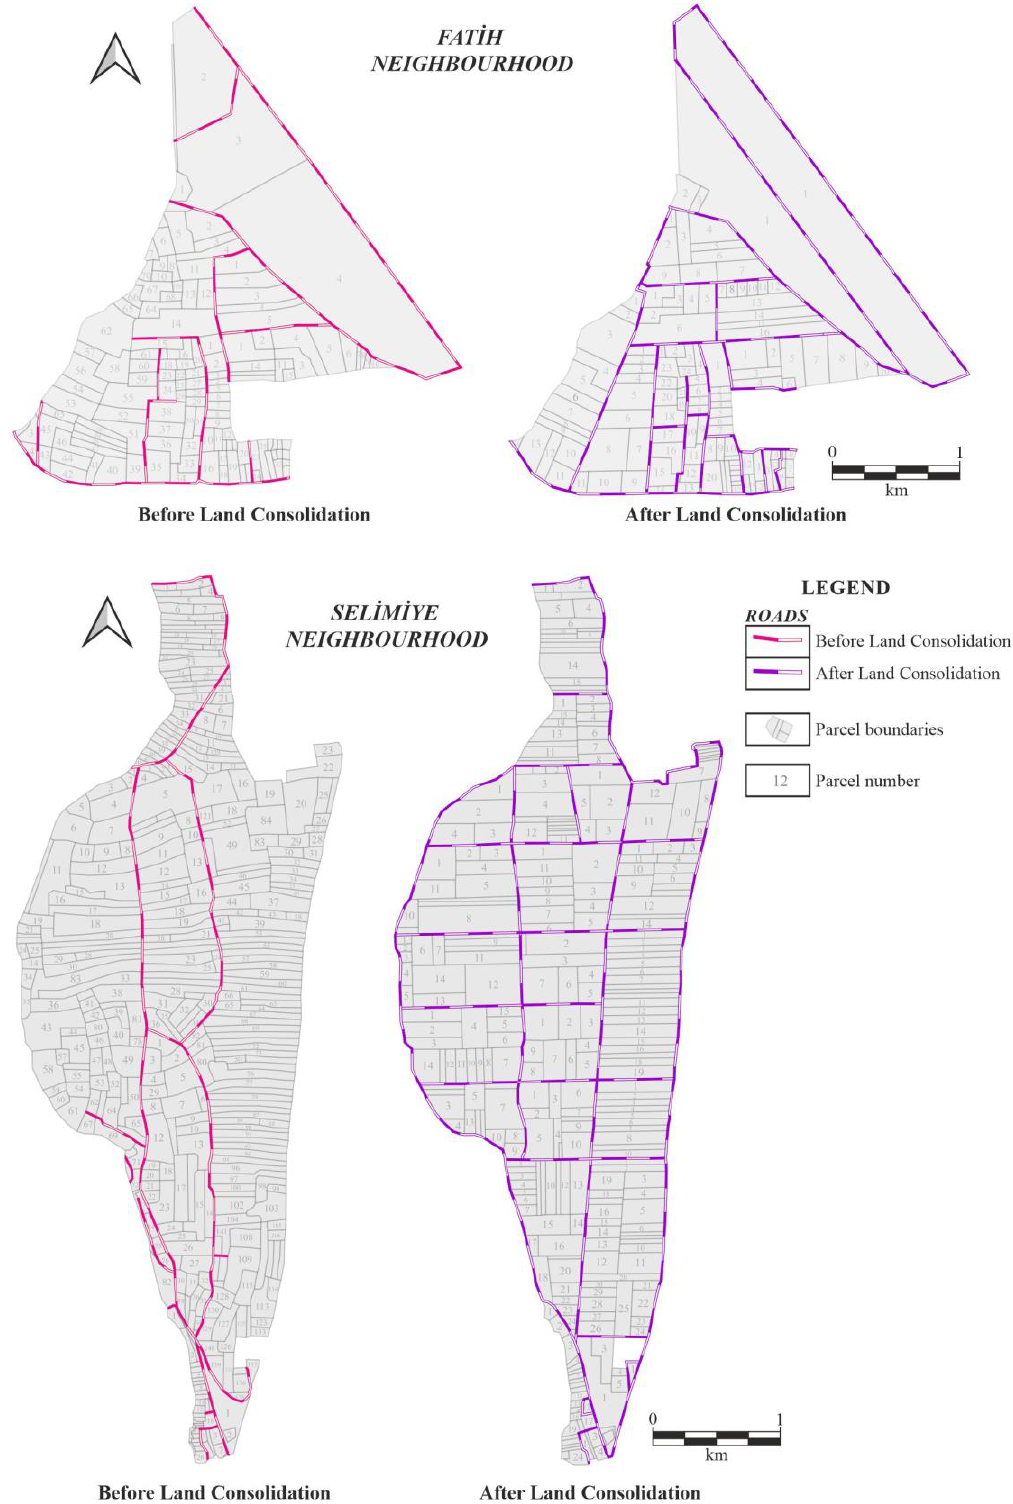
Figure 2. Changes in the layout of the transport network in the study areas (before and after